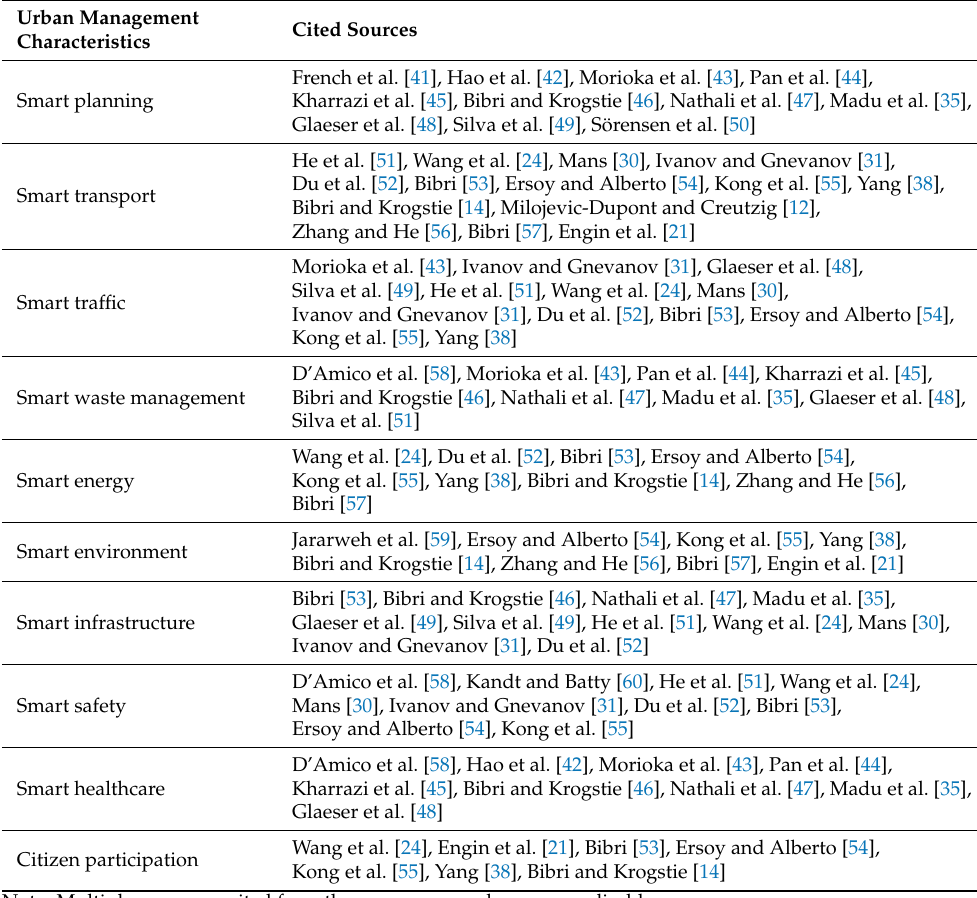
Table 3. Key dimensions of data-driven urban